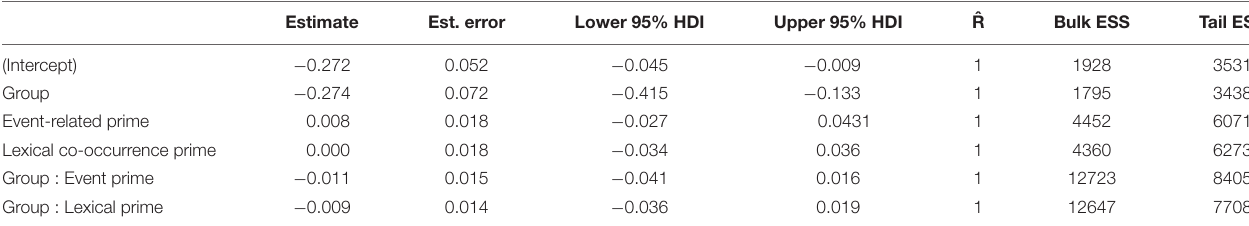
Model 4: Primed Naming Response Time in Participants With